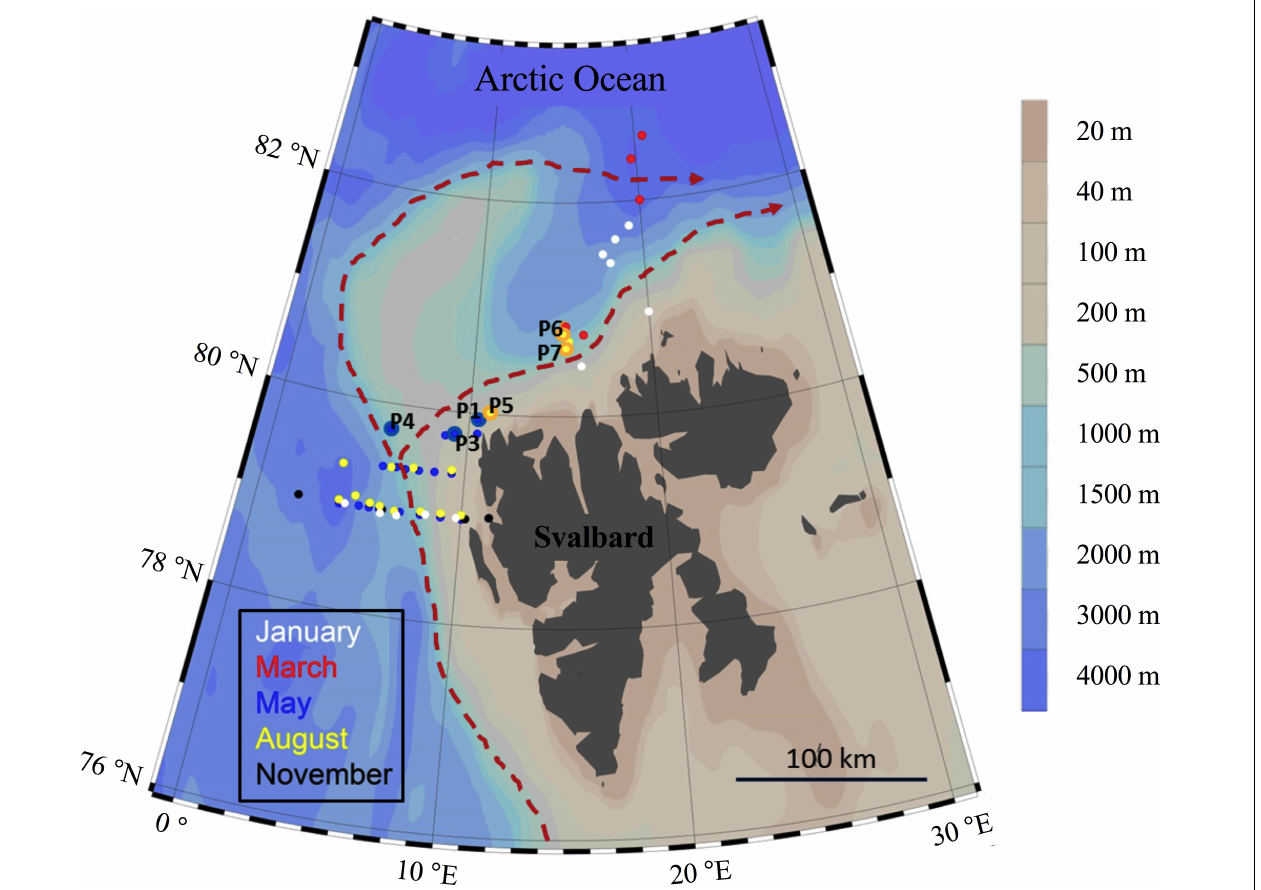
FIGURE 1 | Overview of the stations sampled during five cruises in 2014. The process stations (P1–P7) are marked. The red dashed line indicates the major flow patterns of warm Atlantic Water into the Arctic Ocean.